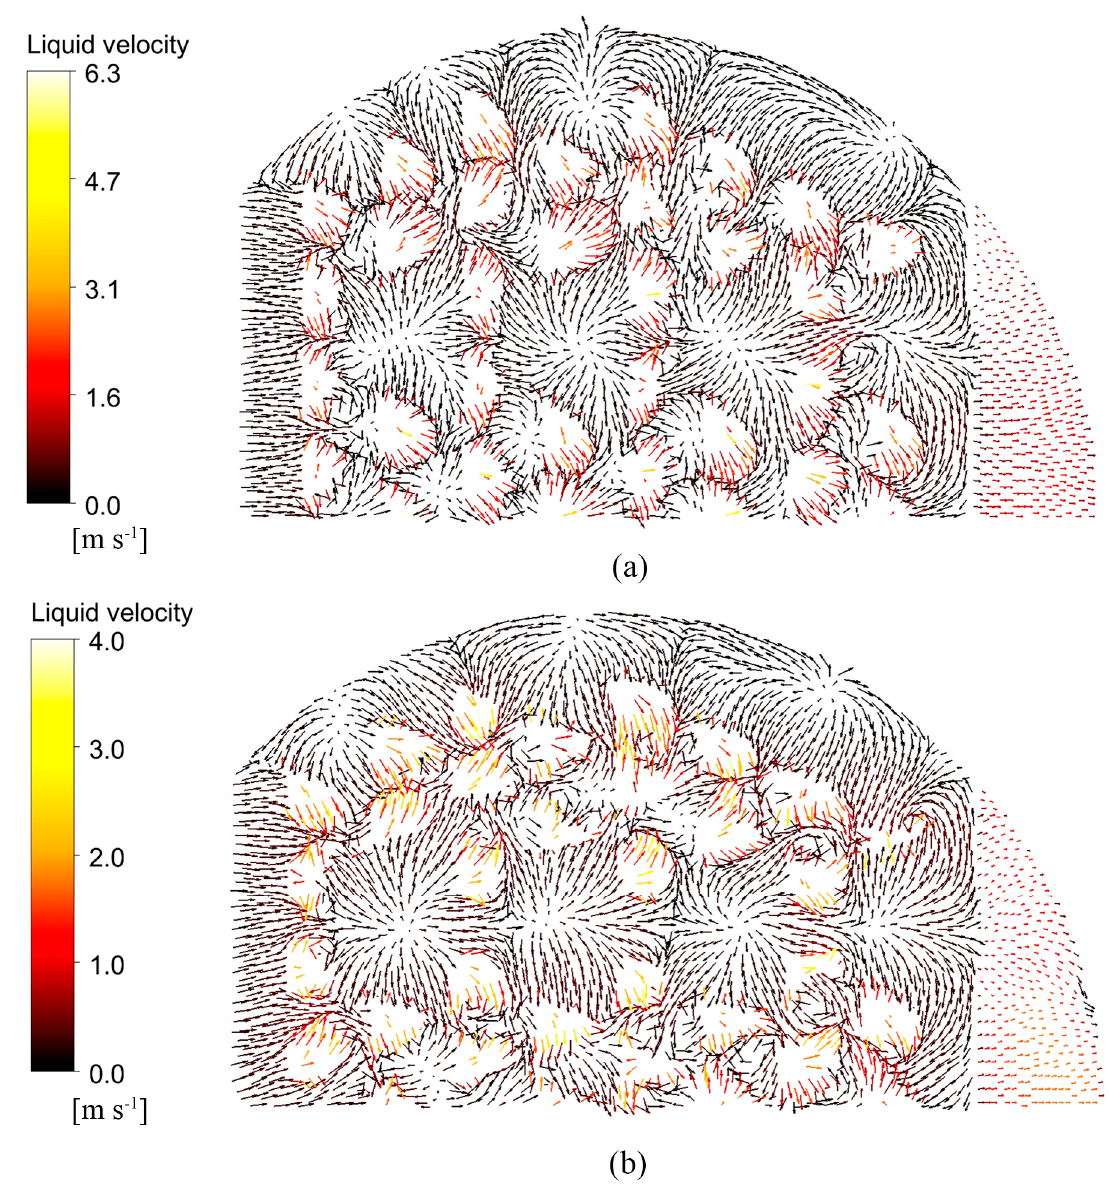
Figure 22. Liquid velocity vector snapshots of the top view at y = 15 mm: ( a ) t = 26; ( b ) t = 18.5. The gas–liquid phase flow line distribution of the parabolic–shaped guided valve tray at t = 26 at a particular moment after the calculation reaches stability is shown in Figure 23: blue indicates the liquid phase flow line, and yellow indicates the gas phase flow line. As seen from the diagram, the liquid phase moves in the direction of the liquid flow in the column tray, over the overflow weir to the downcomer, and then out through the bottom gap of the downcomer. Due to the gas phase’s stirring and the valve’s guide effect, the liquid phase does not flow straight through, but some swirls will be formed during the flow. The gas phase’s main flow direction is perpendicular to the tray, and its flow line has a significant bend in the gas–liquid transfer zone. Due to the guiding effect of the valve, some gas phase flow lines appear near the exit weir and form a vigorous mixing with the liquid phase. Once the gas phase has passed through the liquid layer, it is unaffected by the valve and will flow in a straight line and out of the top valve hole. The red and green surfaces indicate the equivalent surfaces for liquid phase fractions of 99% and 1%, respectively. As can be seen, most of the liquid phase is concentrated at the bottom of the tray,